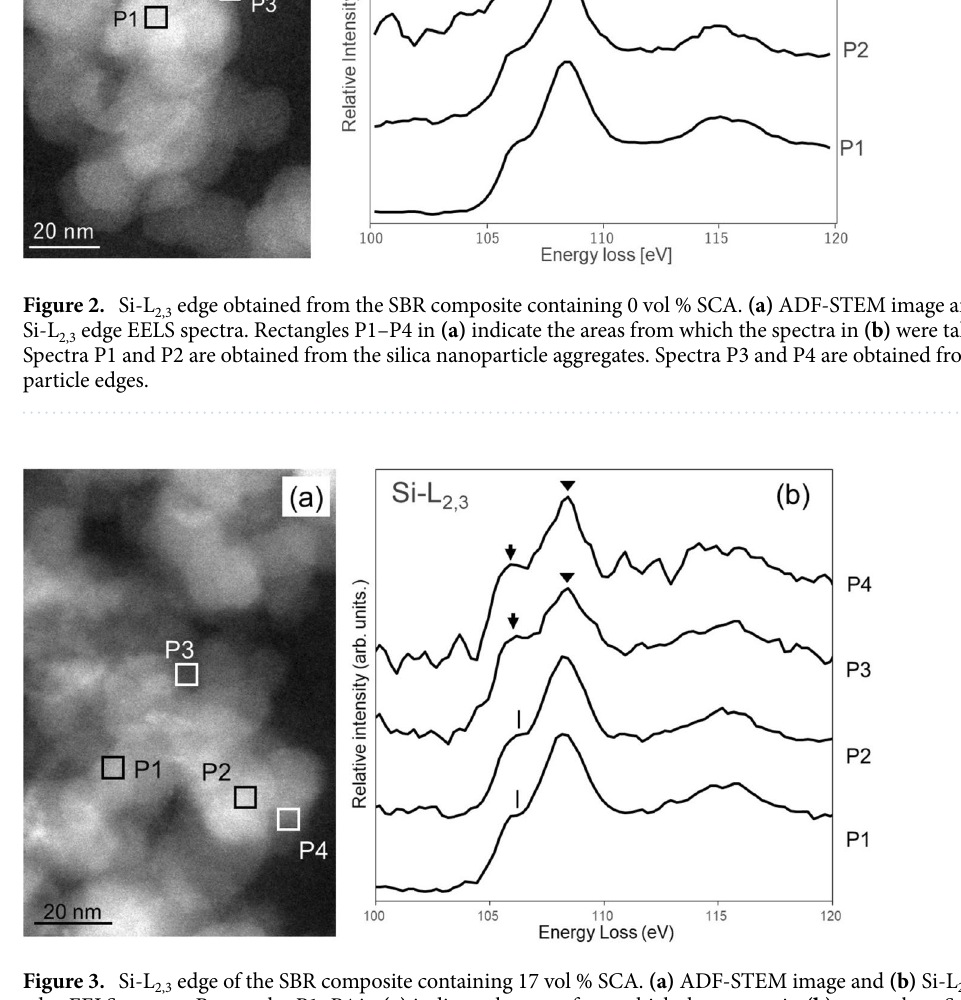
Figure 3. Si-L 2,3 edge of the SBR composite containing 17 vol % SCA. (a) ADF-STEM image and (b) Si-L 2,3 edge EELS spectra. Rectangles P1–P4 in (a) indicate the areas from which the spectra in (b) were taken. Spectra P1 and P2 are obtained from the silica nanoparticle aggregates. Spectra P3 and P4 are from the particle edges. The spectral distributions at the silica interface are broader than those of the